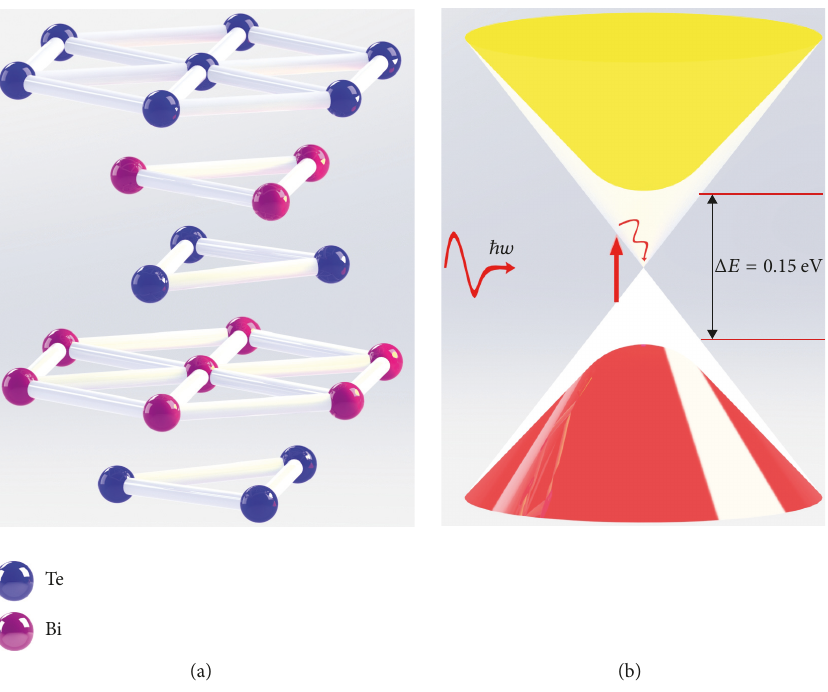
Figure 6: (a) The atomic structure and (b) the band structure of TI: Bi 2 Te 3